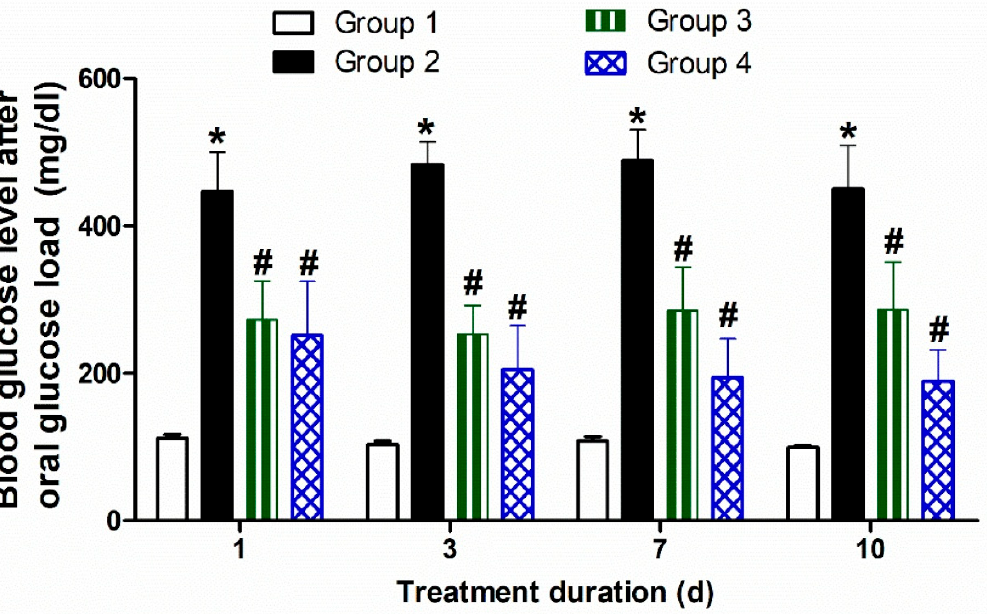
Figure 11. Influence of oral alogliptin solution and subcutaneous optimized ISGI formulation on blood glucose level of rats. Values are expressed as mean ± standard error of mean. * p < 0.05 in comparison to group I. # p < 0.05 in comparison to group II.